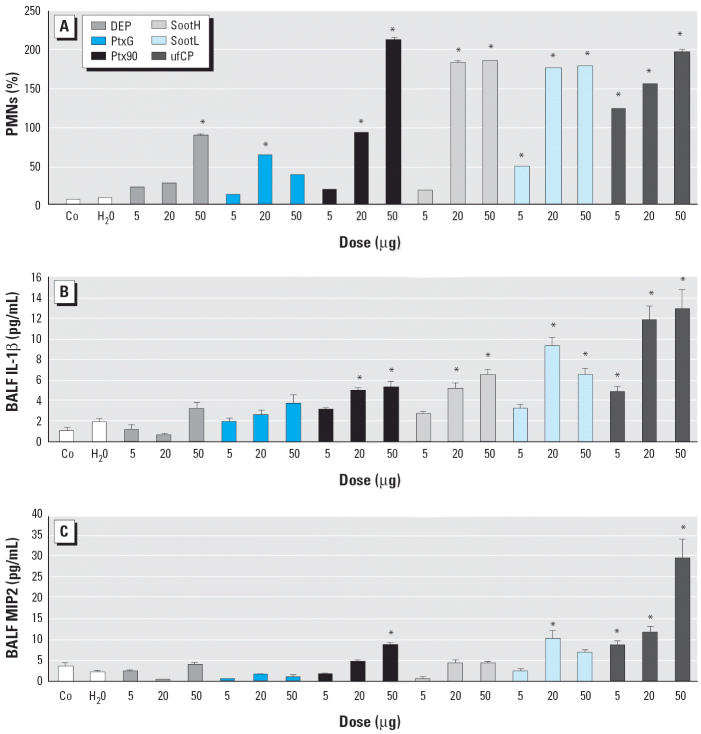
Particle-dependent elevation of PMNs (A), IL-1β (B), and MIP2 (C) in BAL from noninstilled (Co) and water-instilled (H2O) control mice and mice instilled with water, DEP, PrintexG (PtxG), Printex90 (Ptx90), SootH, SootL, and spark-generated ufCP of increasing inflammatory potency. Results are expressed as a function of gravimetric dose (5, 10, and 50 μg). Bars represent mean ± SE of eight animals.*Significantly elevated compared with Co and H2O controls (p < 0.05).